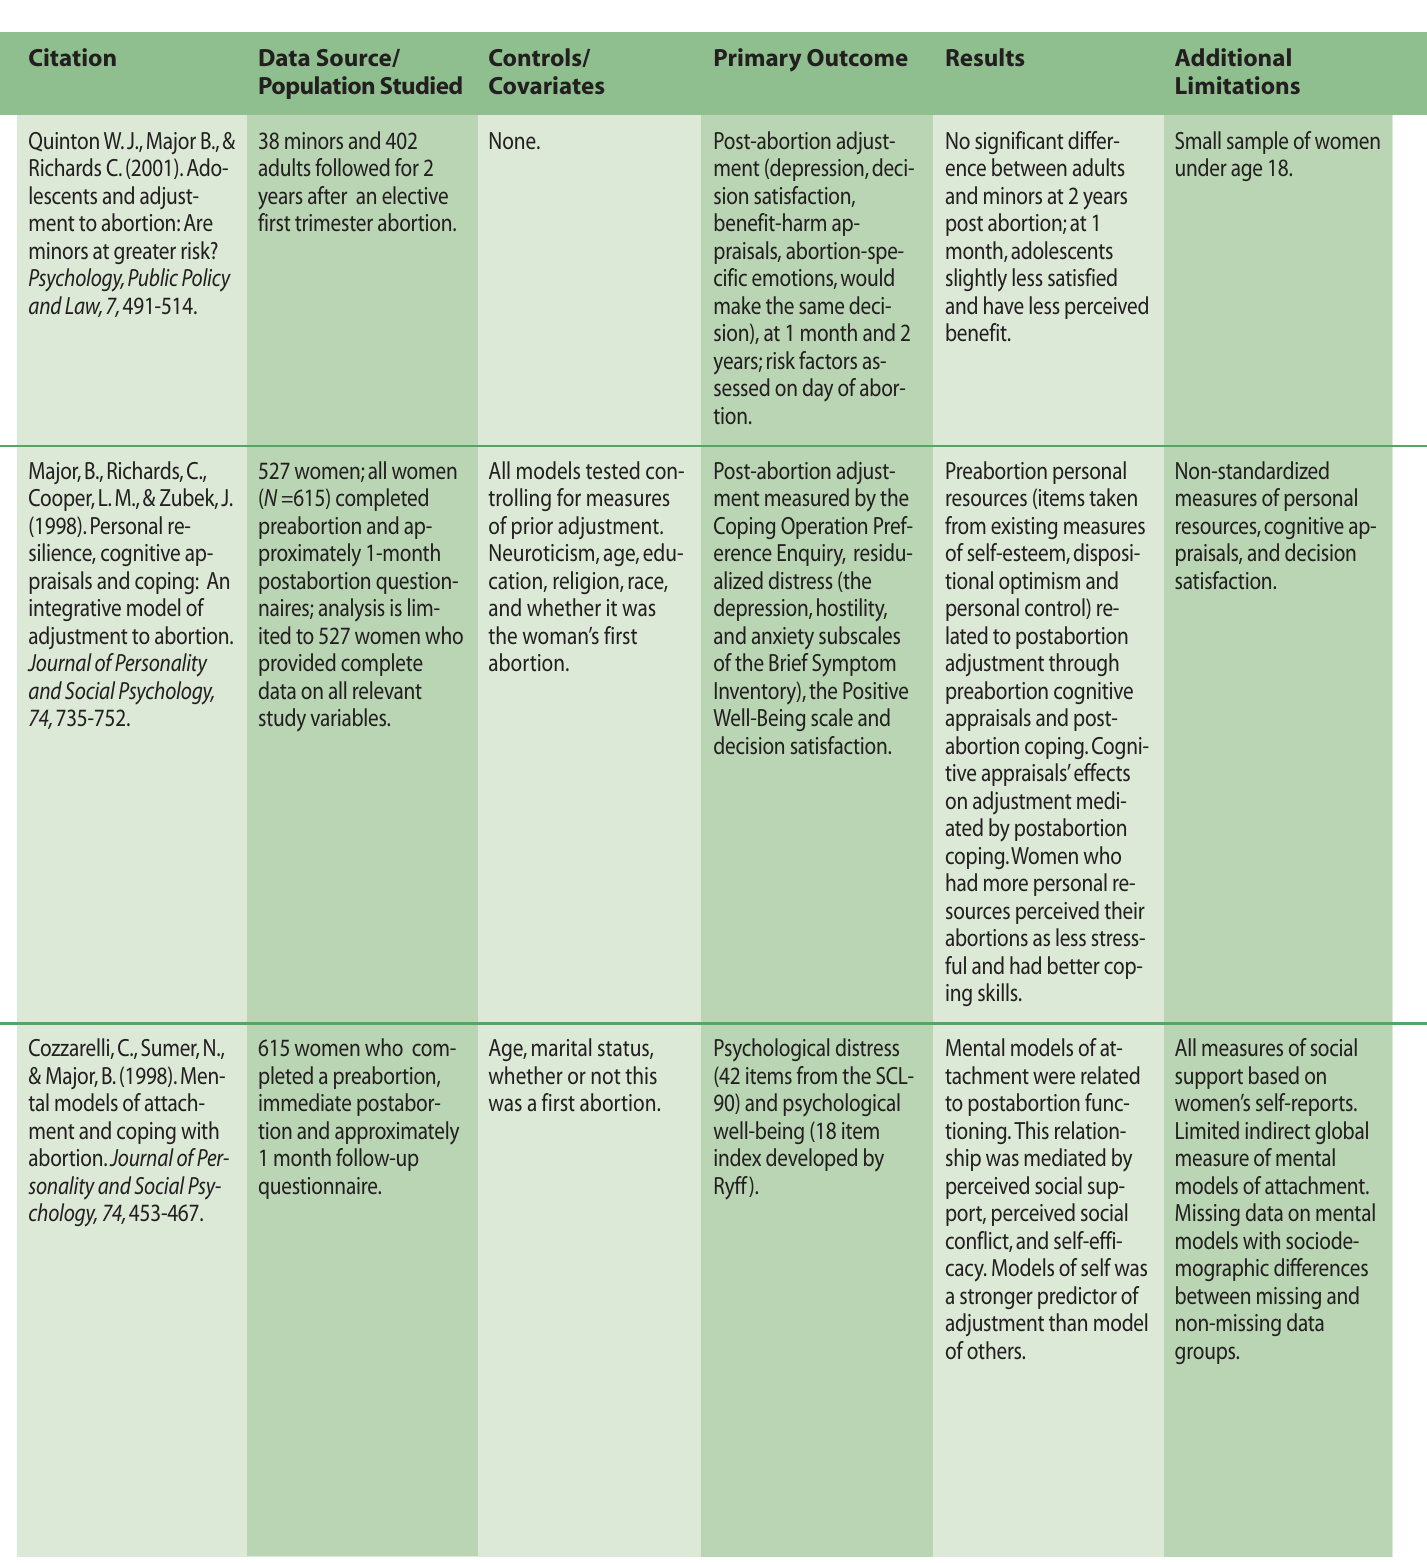
Table 5: U.S.Samples of Abortion Group(s) Only/No Comparison